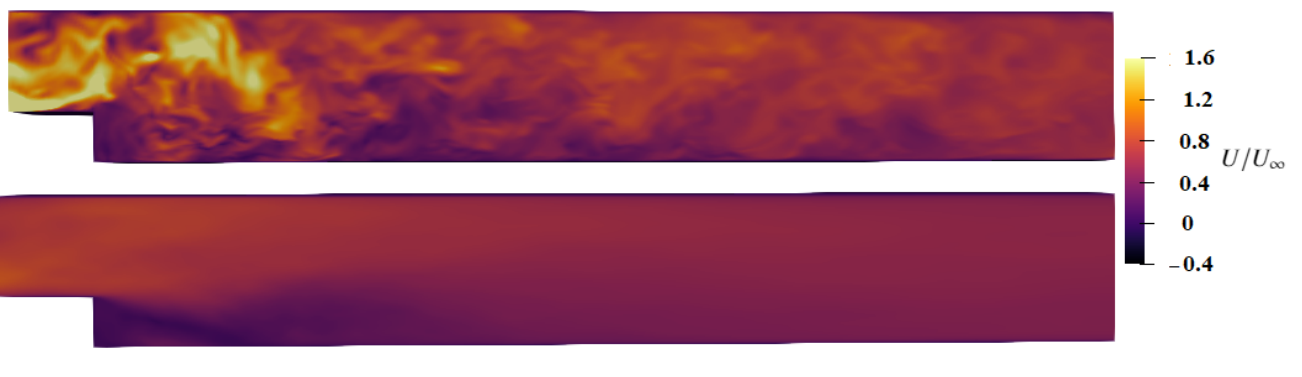
Figure 9. The instantaneous ( upper ) and mean velocity ( lower ) in the isothermal wall